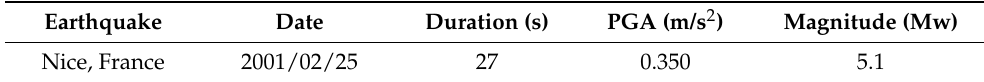
Table 5. The earthquake’s base motions considered.